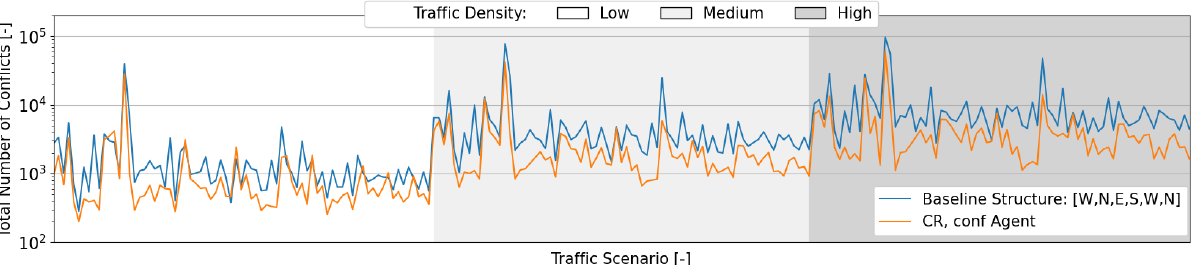
Figure 14. Mean total number of pairwise conflicts during testing of the RL agent. All traffic densities had 75 traffic scenarios, with the initial direction(s) and the number of turns following the same order as shown during the training phase.